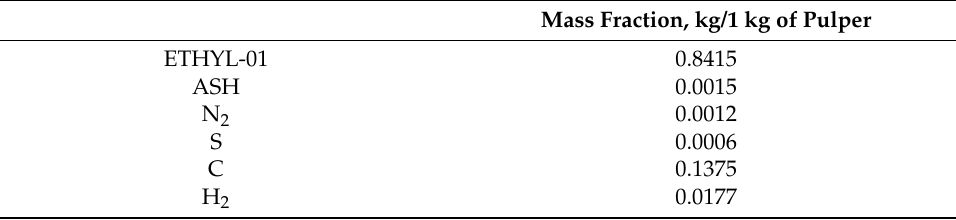
DEPOLYM. Figure 4. Thermochemical scheme of the MR pyro-gasification plant. Figure 4. Thermochemical scheme of the MR pyro-gasification plant. Table 4. Estimated chemical composition for the